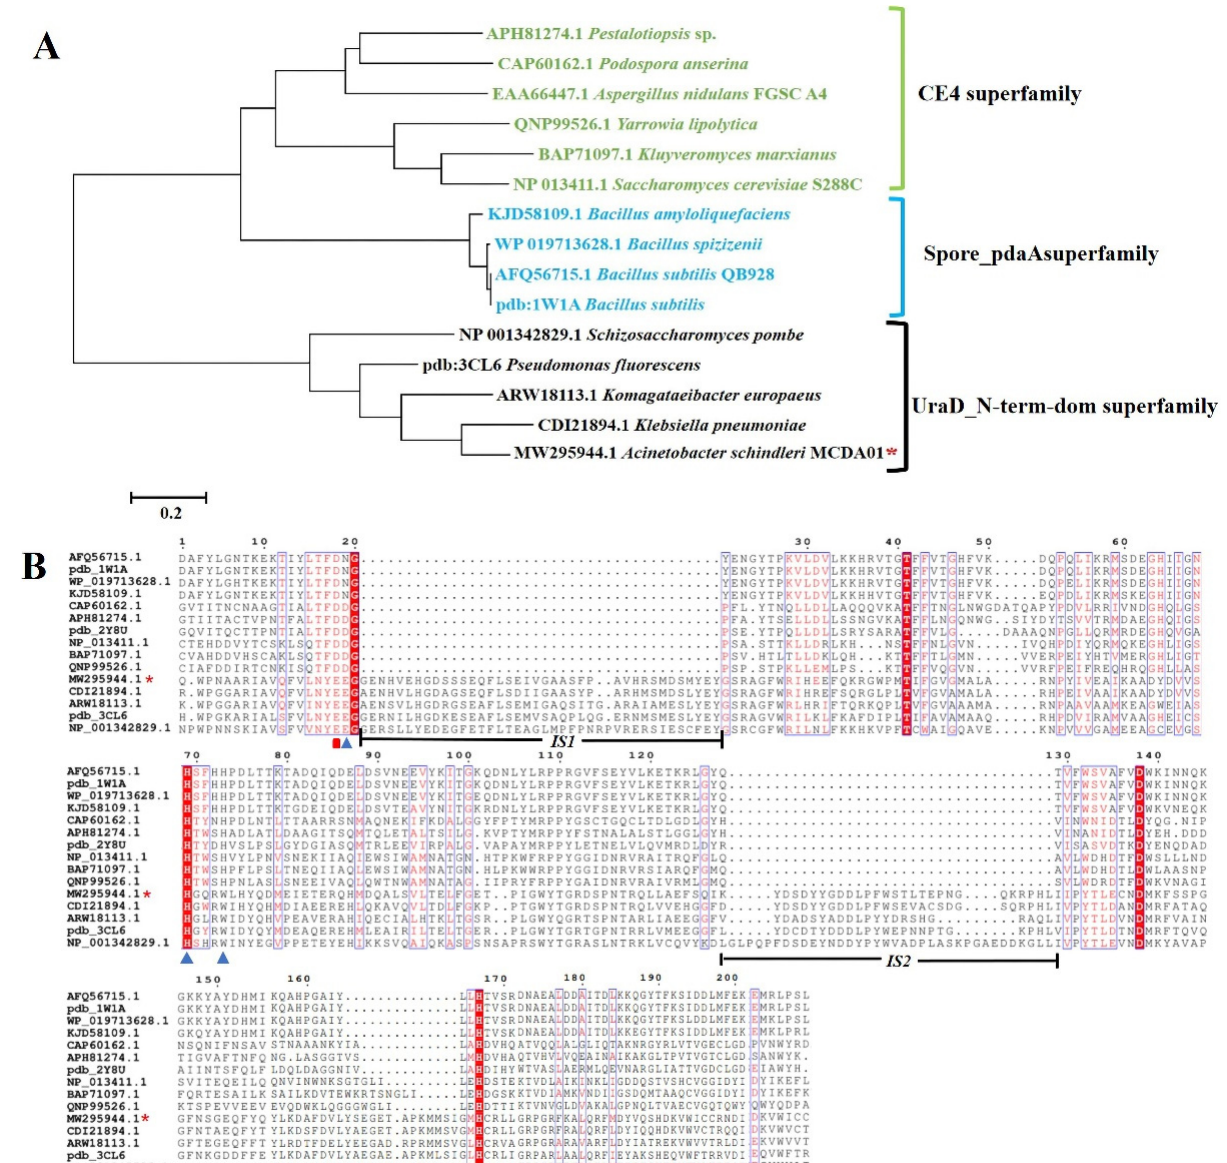
Figure 3. Bioinformatics analysis of As CDA: ( A ) phylogenetic analysis of neighbor-joining phylogenetic tree; ( B ) multiple amino acid sequence alignment: the metal binding triads are indicated with blue triangles; the catalytic base and catalytic acid are indicated with red rectangles and green rectangles, respectively.